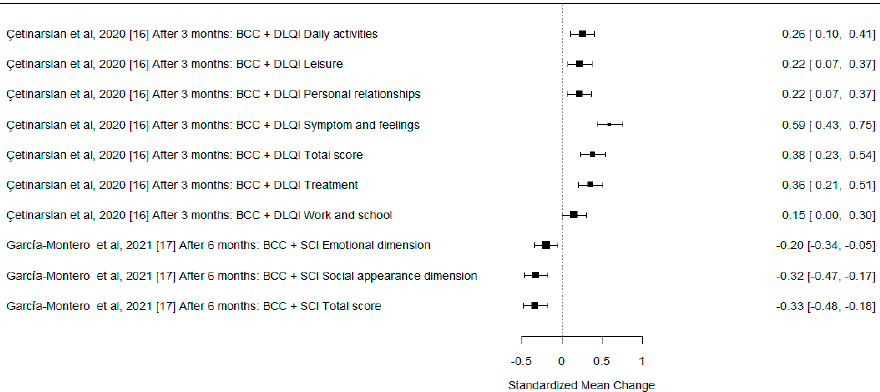
Figure 2. The forest plot for differences in the preoperative and postoperative QoL measures for the overall group (not stratified by histological type). SMD with 95% CI.